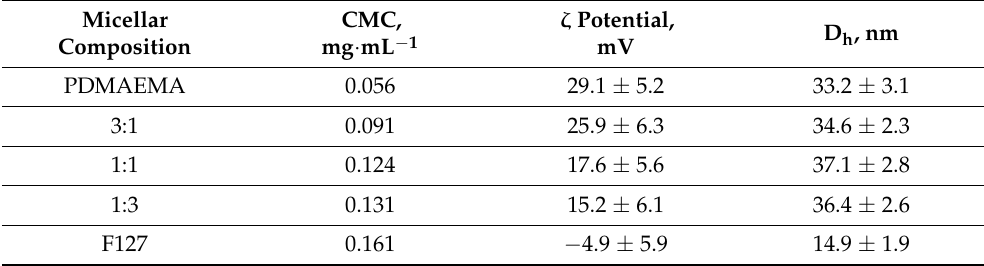
Table 1. Critical micellization concentration, hydrodynamic diameter, and ζ -potential values of SCPMs and MPMs based on PDMAEMA-PCL-PDMAEMA and Pluronic F127 triblock copolymers. Measurements were performed at 25 °C.